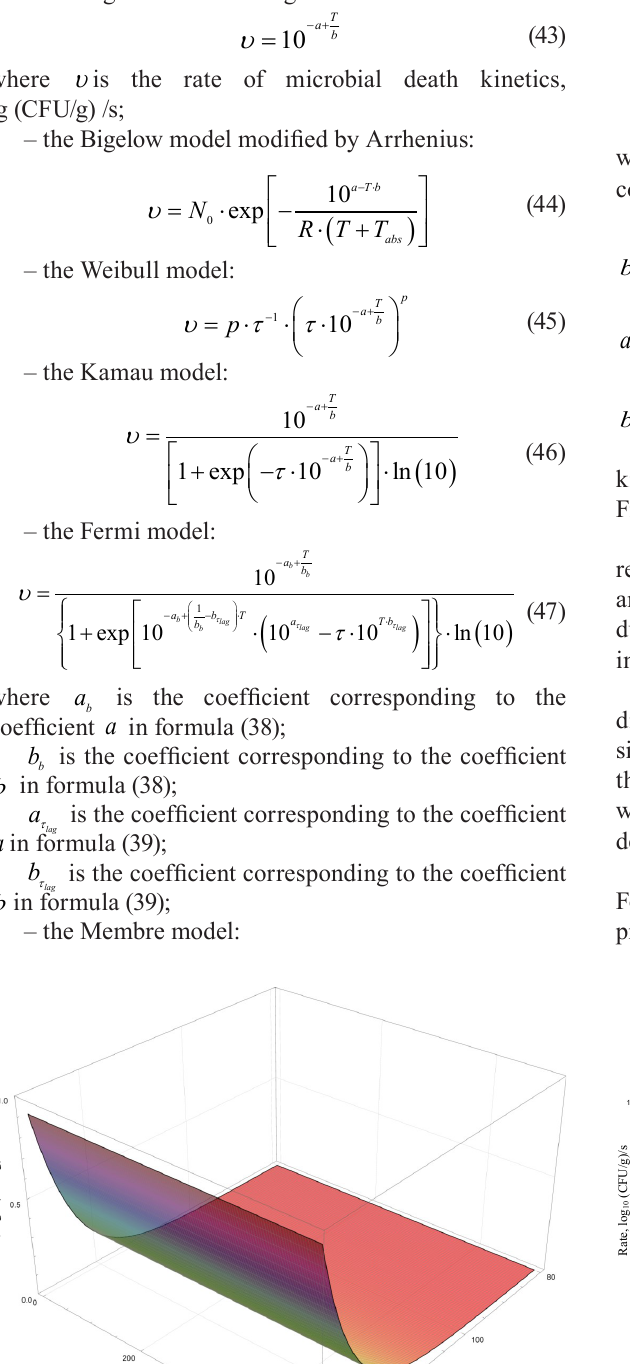
Figure 9 Model of the rate dynamics for microbial death kinetics of A. acidoterrestris during heat treatment.(a) Bigelow model, (b) the Bigelow model modified by Arrhenius.